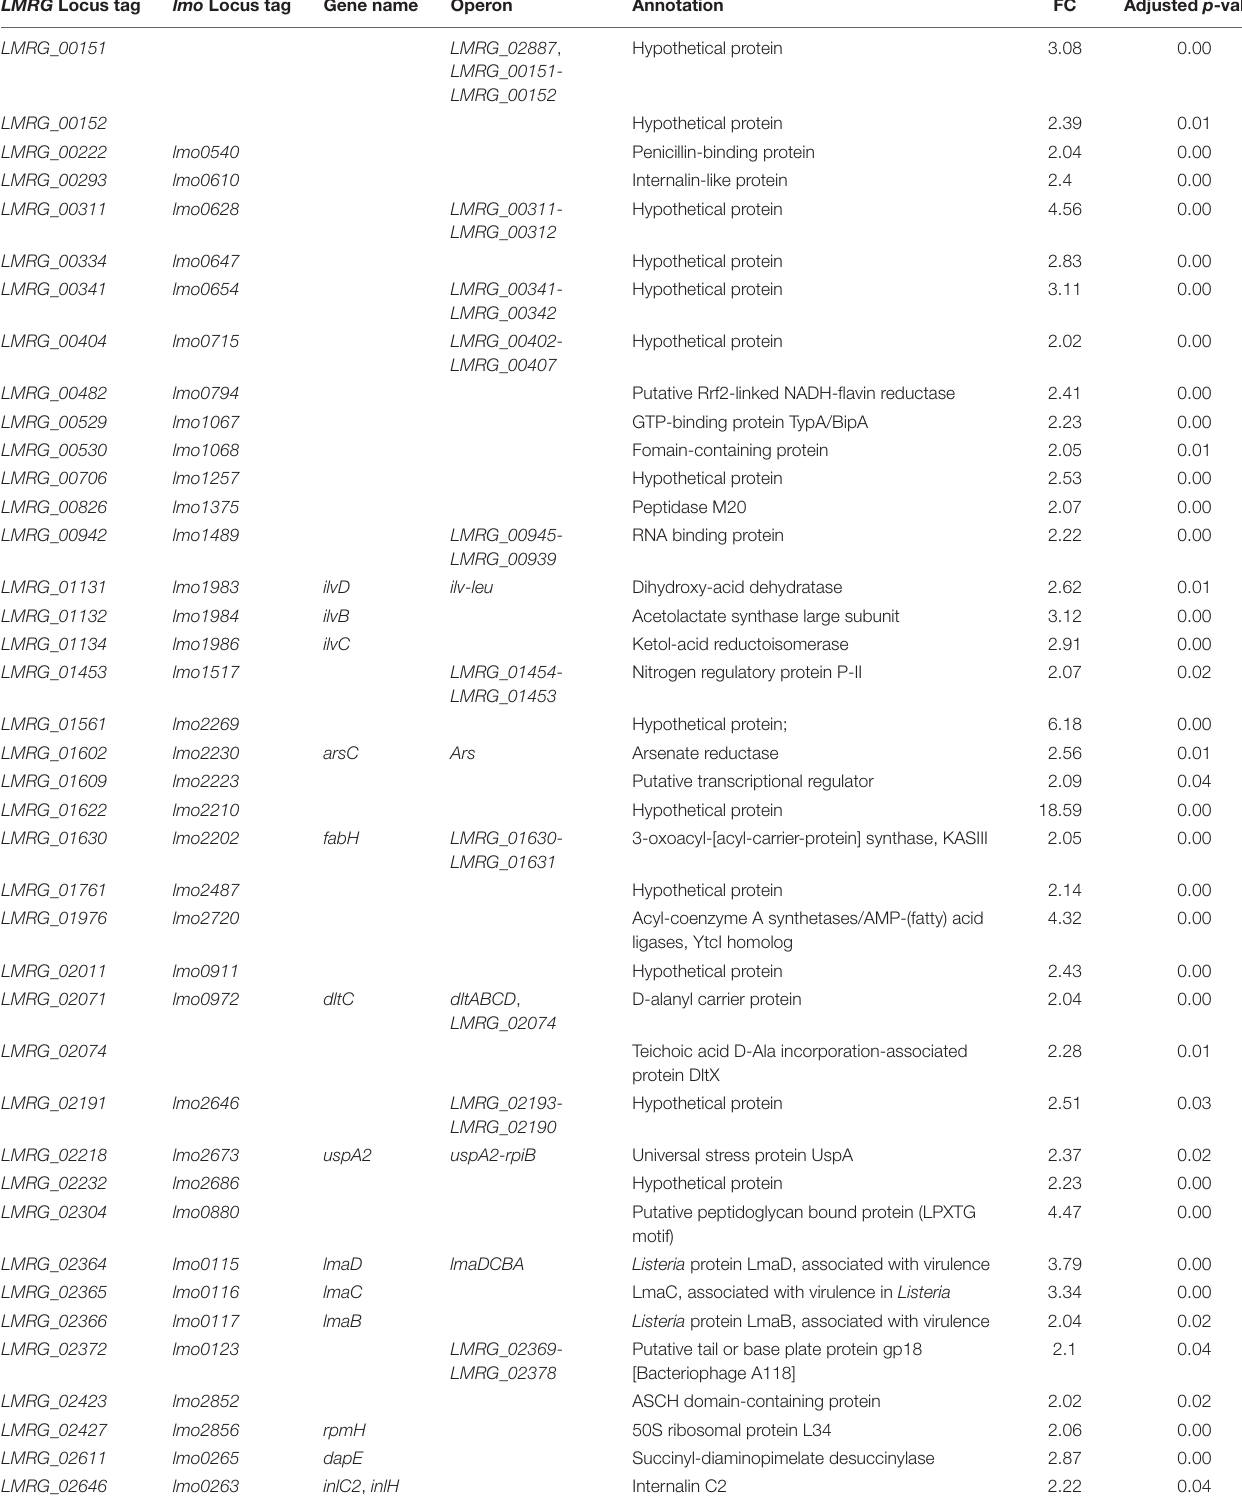
TABLE 2 | Differentially expressed genes under bile exposure in L. monocytogenes 10403S wild type. LMRG Locus tag lmo Locus